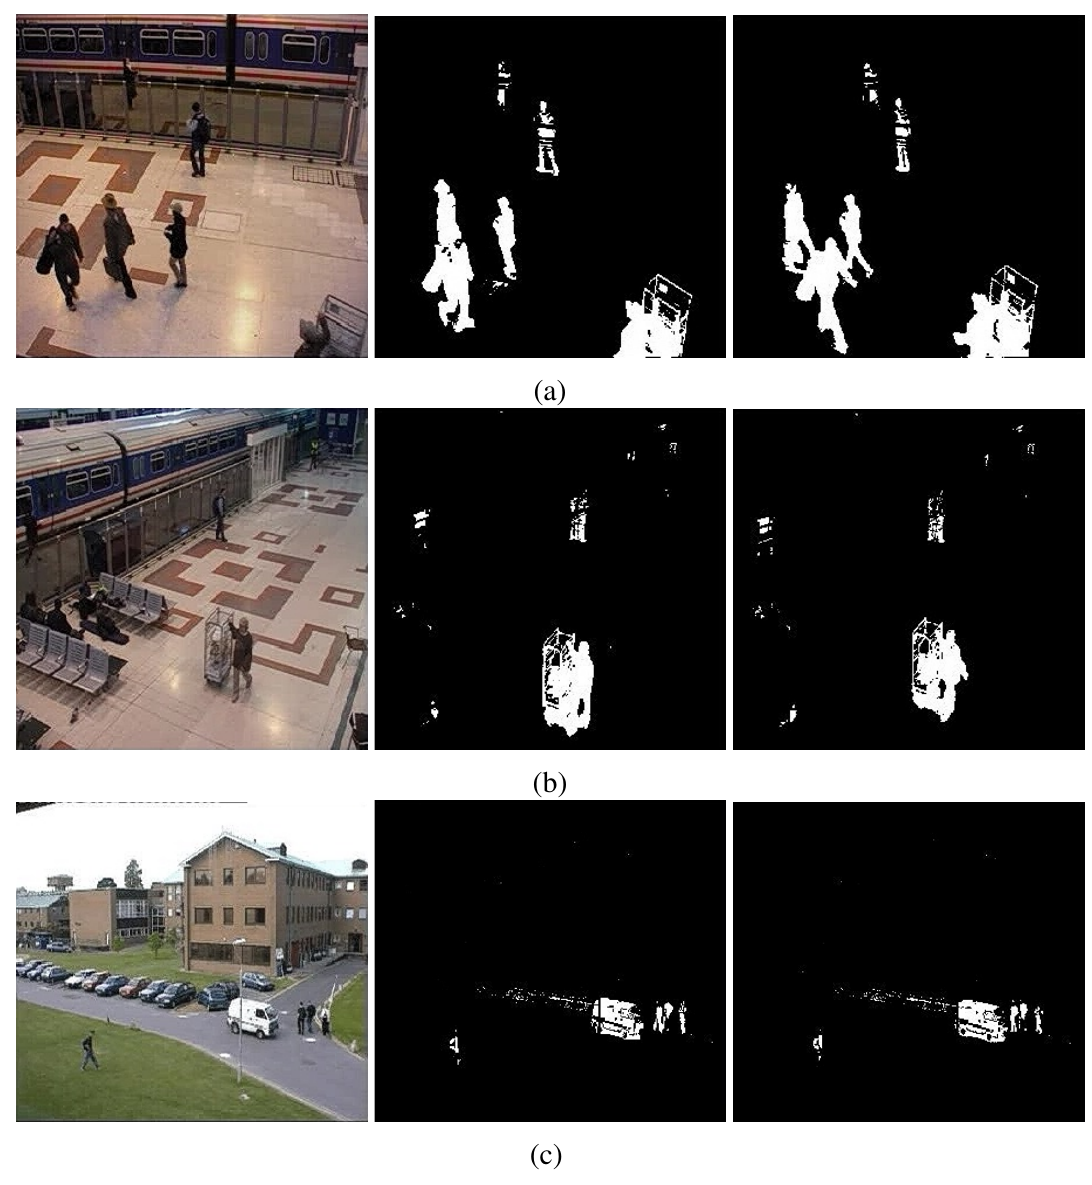
Figure 3. Foreground detection from image sequences of the PETS database [17, 18] using the proposal. The sequences in (a) and (b) correspond to cameras monitoring a train stop; the sequence in (c) corresponds to a car parking. The foreground detection is performed without spatial filter. The level of resolution is higher and soft shadows are discarded